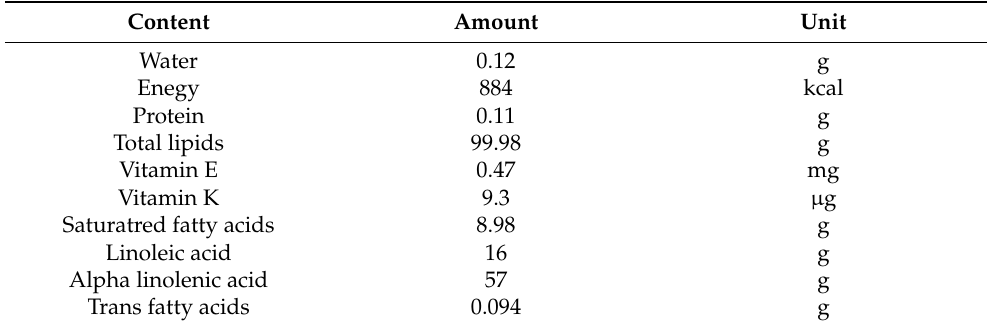
Table 3. Flax oil nutritional value per 100 g of oil. Data retrieved from